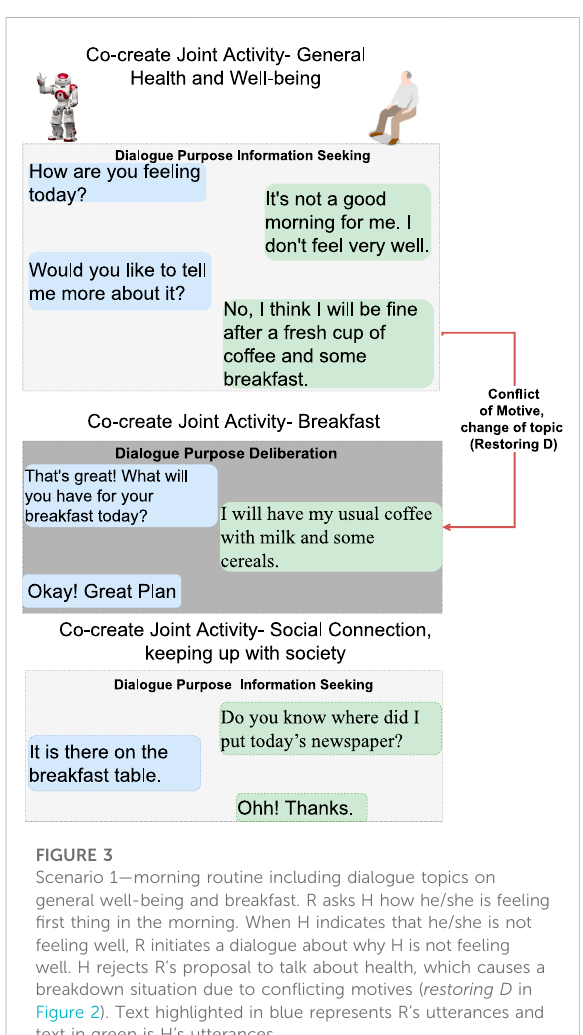
FIGURE 4 Scenario 2 — morning routine after breakfast when H reads or watches the news for the purpose of keeping up with society. When H expresses distressing emotions, which are detected by R, R asks about what is happening in the news. H informs R about new regulations around COVID-19. The dialogue unfolds into a proposal by R to talk to the son about this situation, after which H indicates he/she feels relieved. No breakdown situations occur in this dialogue. Text highlighted in blue represents R ’ s utterances, and text in green is H ’ s